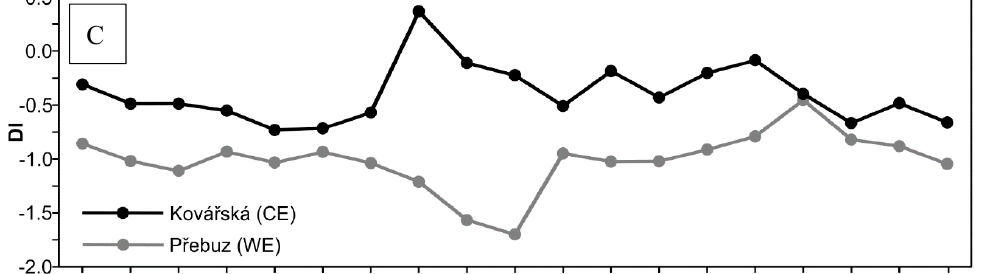
Figure 4. Relative frequency of the Disturbance Index (DI) classes calculated for the forest areas at the western (WE) and central (CE) Ore Mountains Class 1—less disturbed areas, Class 2—most common disturbance level, and Class 3—more disturbed areas ( a and b ). Mean DI values calculated for the Norway spruce stands sampled during the field campaigns in 1998 and 2013 ( c ).